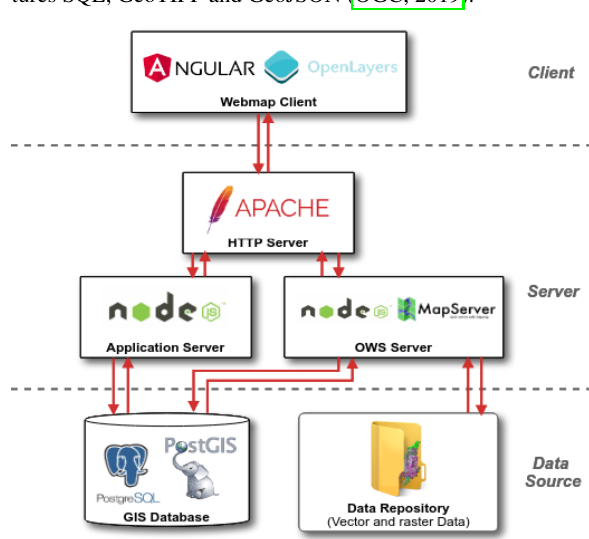
Figure 3. The software architecture of DPAT. The source code of the components is public available at www.github.com/lapig-ufg/d-pat